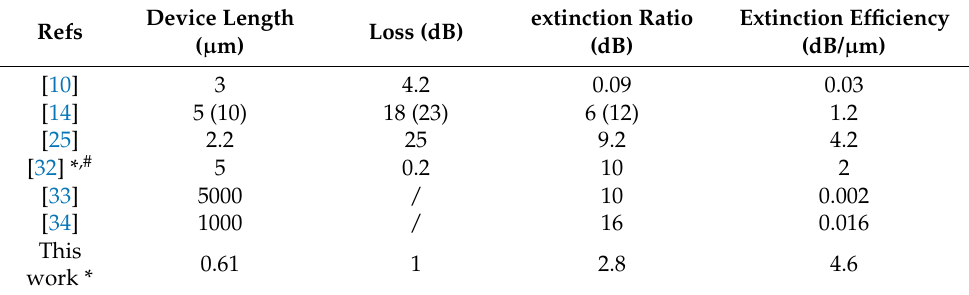
Figure 4. ( a ) Taper length dependence of the optical transmission of the plasmonic memristor at HR and LR states; ( b ) taper length dependence of the extinction ration (ER) and insertion loss of the plasmonic memristor. Table 1. Summary of the performances of some reported plasmonic memristors.